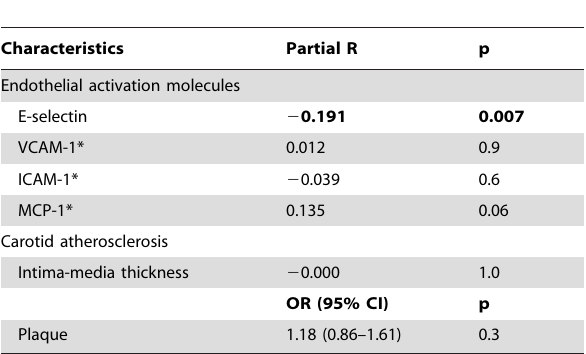
Table 5. Independent relationships of retinol binding protein 4 concentrations with endothelial activation and